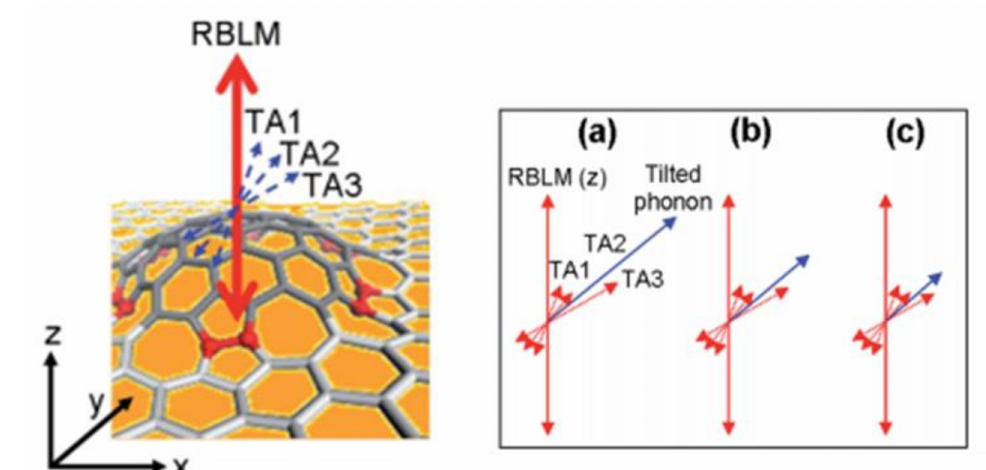
Figure 7. ( Left ) Illustration depicting the probable protruding conformation by combining TA series signals with strong RBLM. ( Right ) (a)~(c) Vectorial combination of tilted vibrational modes (blue) with RBLM vibrational mode (red) direction (tilted vibrational modes: TA1~TA3, dotted red arrow). TA3 signals with varying intensity led to the variation in the magnitude of the tilt formation of CVD-MG [25]. Reprinted with permission from ref. [25].